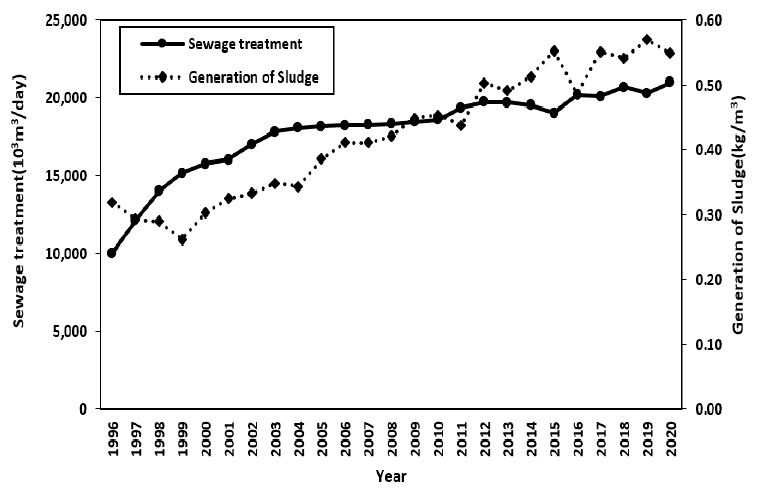
Figure 2. Basic unit of sewage sludge per sewage treatment. The left is the amount of sewage inflow from the STP, and the right is the amount of sewage sludge per sewage treatment.